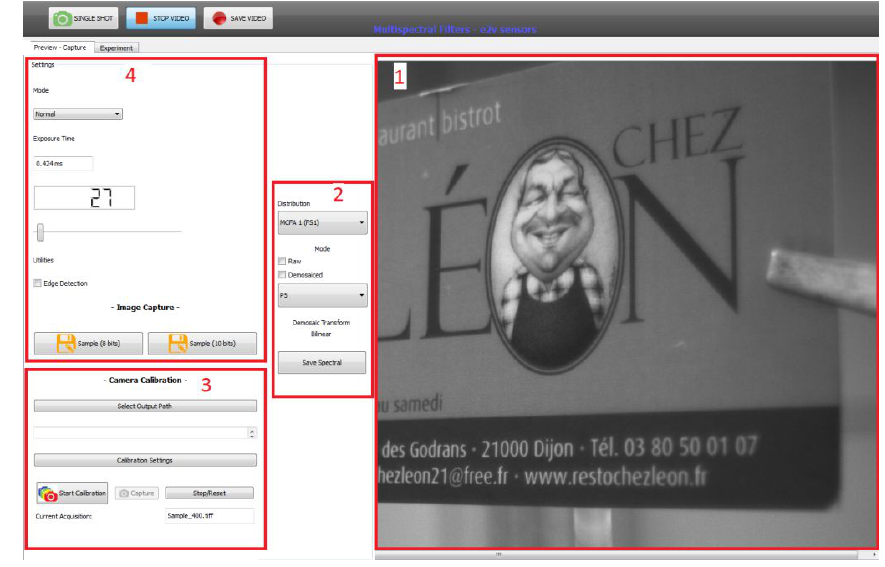
Figure 15. The control software. Application features: 1, video preview; 2, channel and filter selection; 3, characterization tool; 4, setting tools. A preview after bilinear demosaicing is a functionality of the